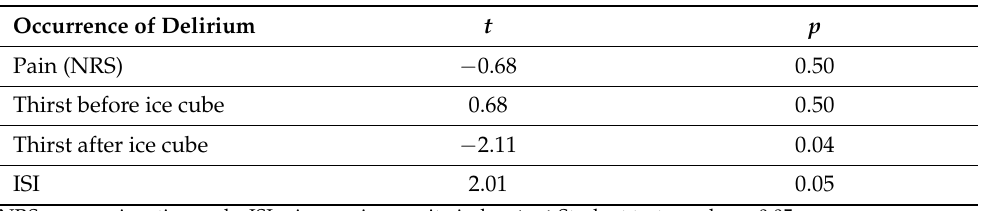
Table 7. Characteristics of the t -Student test indicator and their significance ( p ) for comparison of delirium and delirium groups.